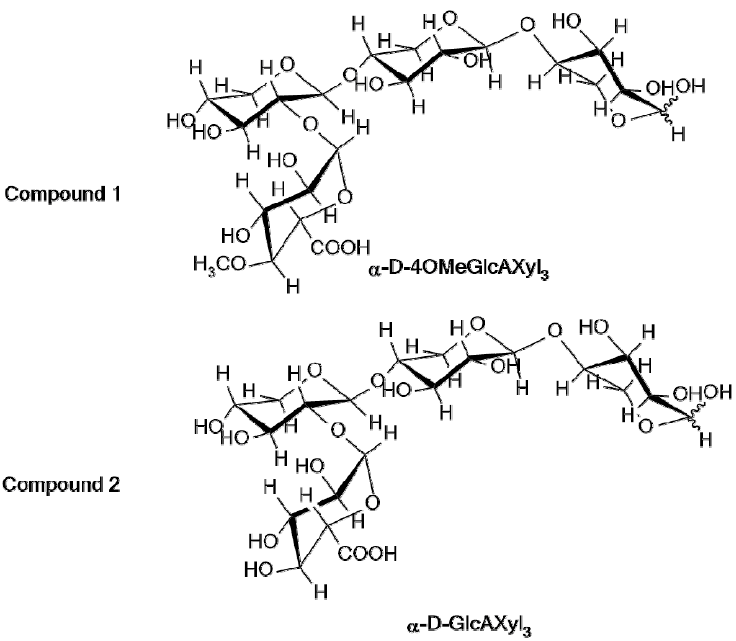
Figure 3. Compounds1and2producedfromhemicelluloseextractof C.cardunculus Figure 3. Compounds 1 and 2 produced from hemicellulose extract of C. cardunculus and ES-GTM endo-xyl.